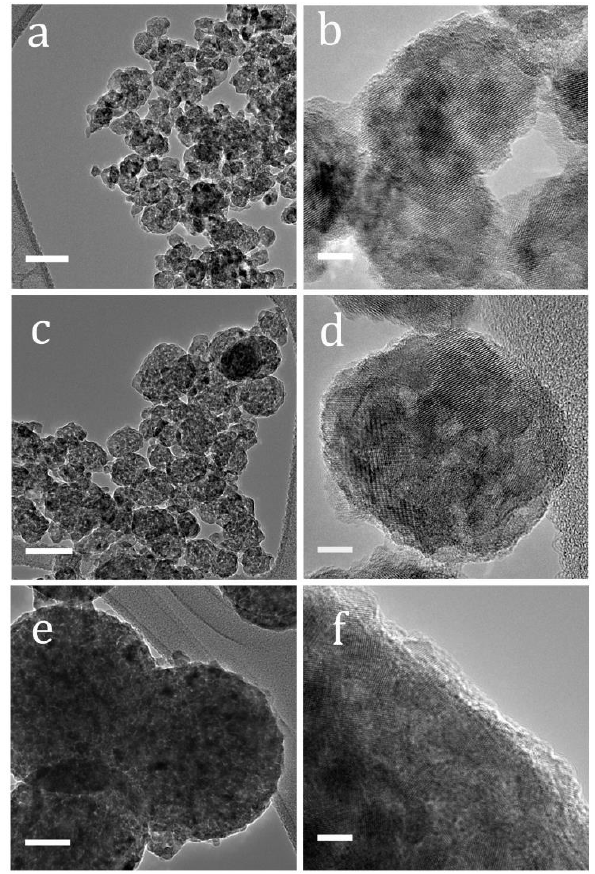
Figure 1. TEM and HRTEM images of sample ( a , b ) S1 ( c , d ) S2 ( e , f ) S3. The scale bars in the TEM images ( a , c , e ) correspond to 50 nm while the scale bars in the HRTEM images ( b , d , f ) correspond to 5 nm.